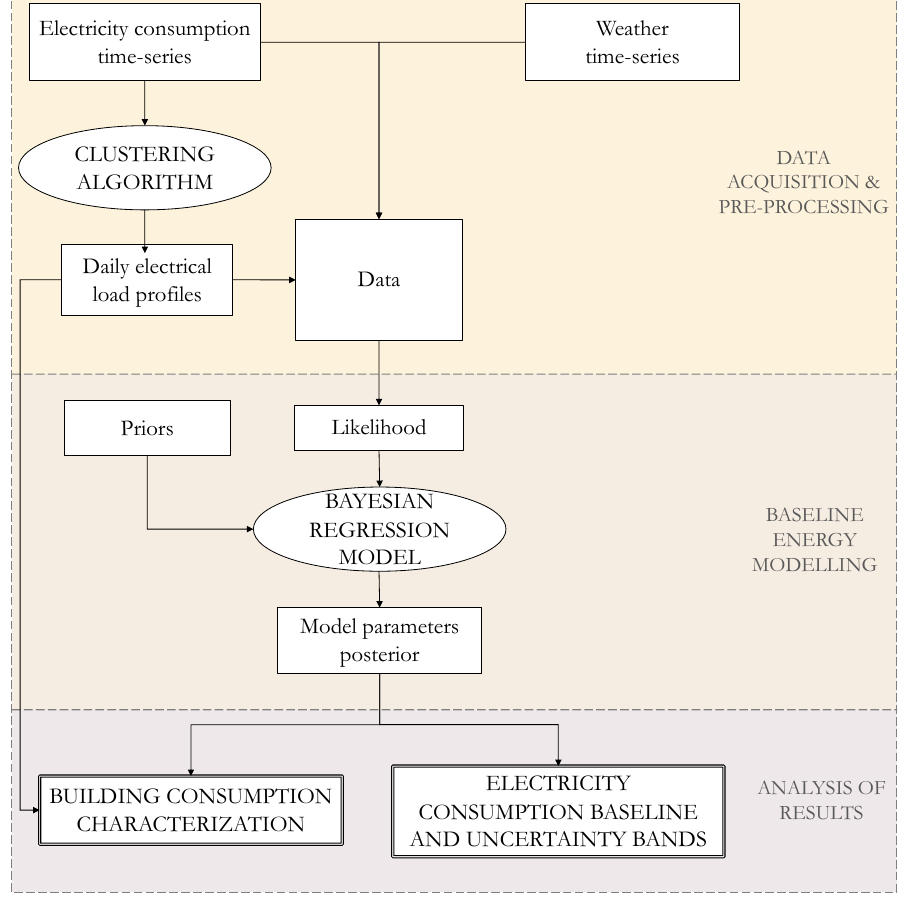
Figure 1. Methodology